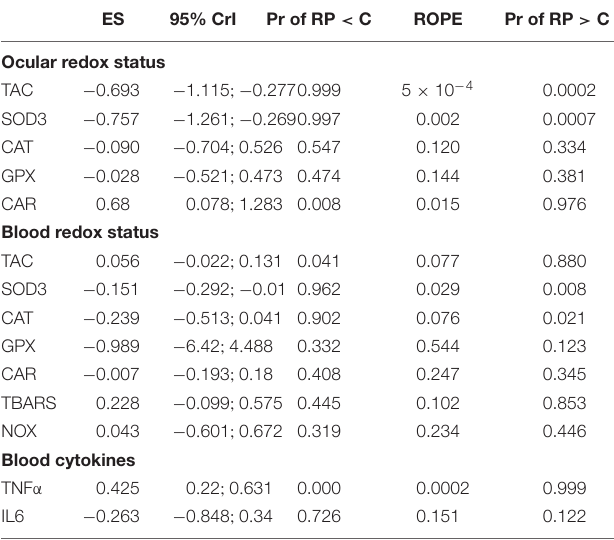
TABLE 3 | Bayesian analysis of baseline redox status and cytokines in controls and RP patients.